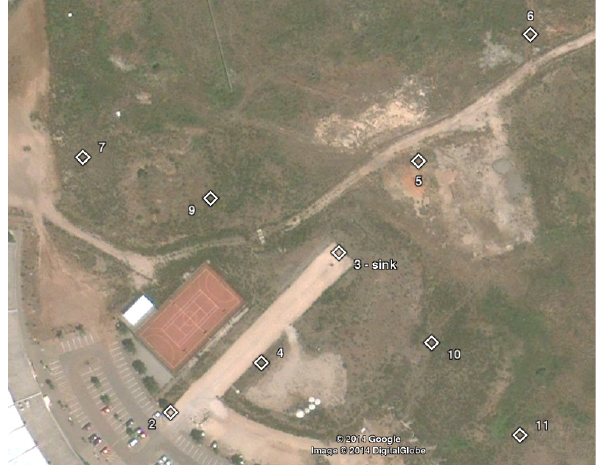
Fig. 22: Spectogram of second bridge crossing Figure 21. Detail of the second bridge crossing. Fig. 21: Detail of second bridge crossing Fig. 21: Detail of second bridge crossing